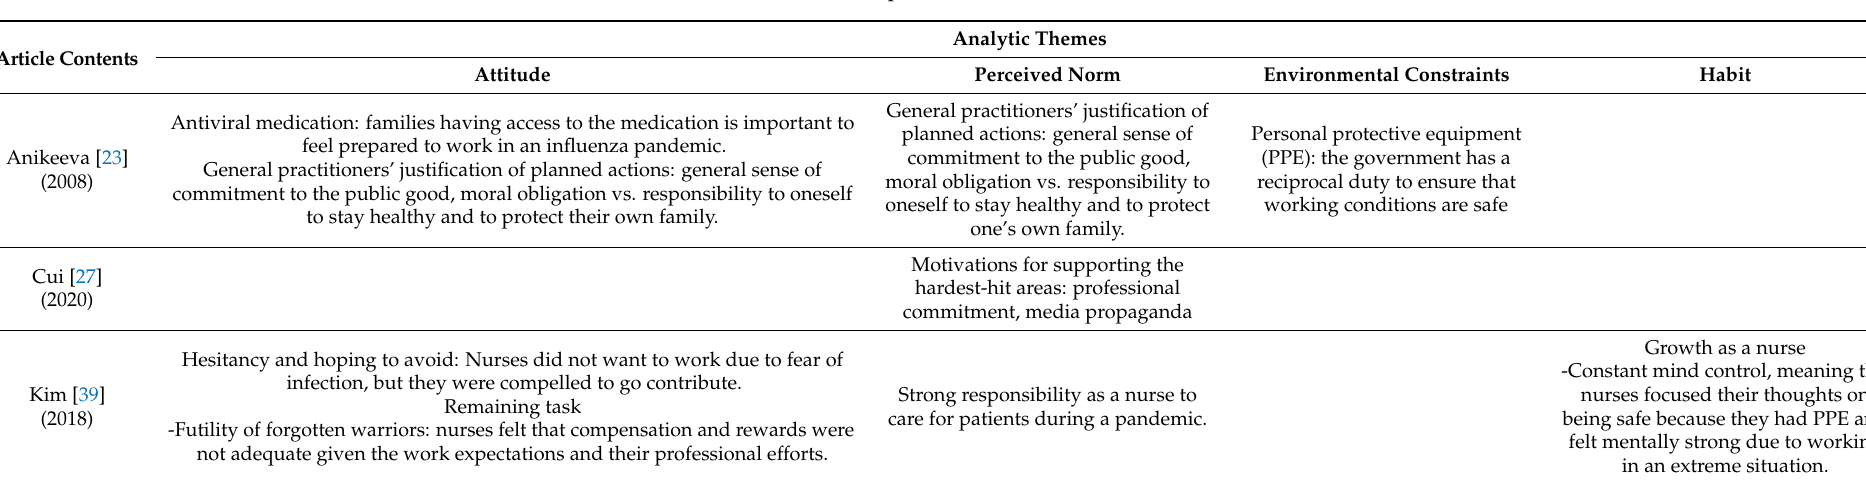
Table 2. Reciprocal translation